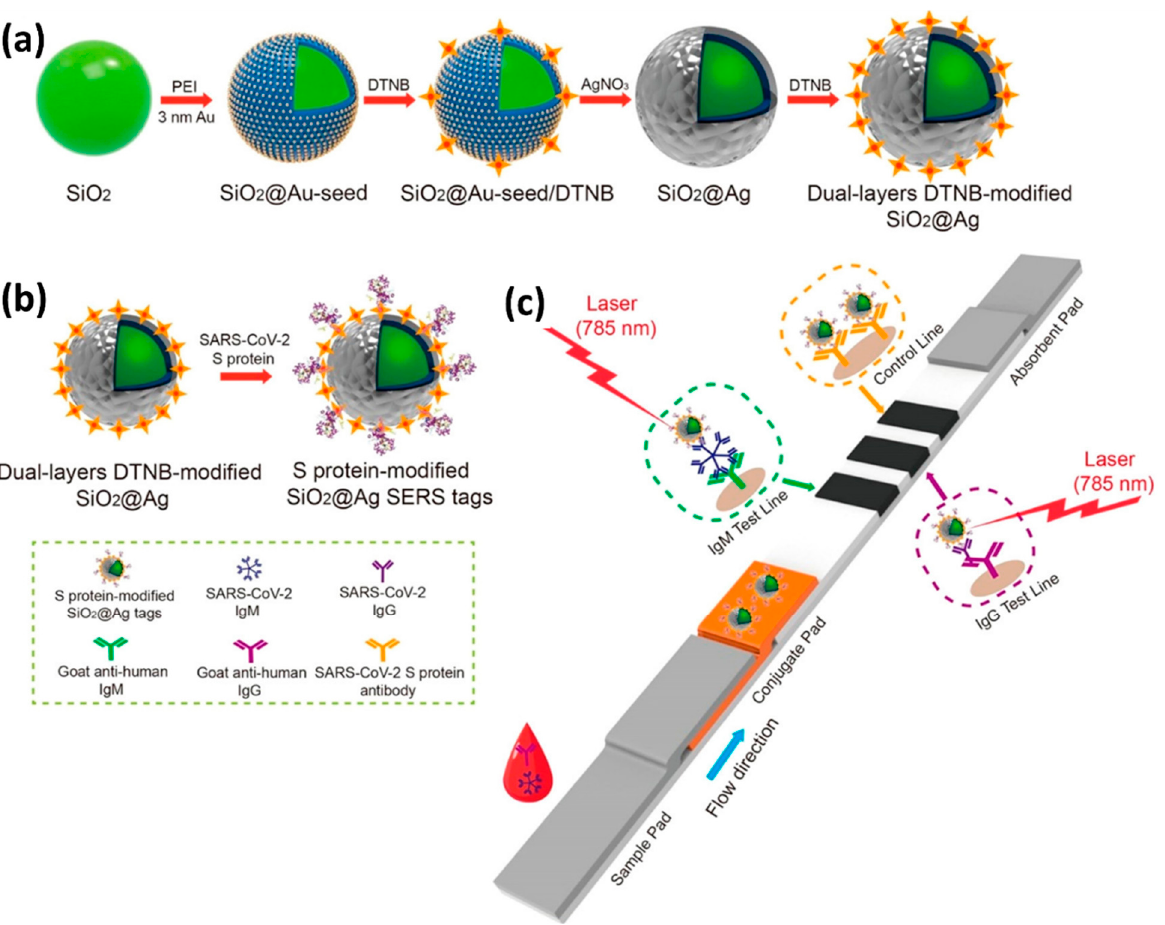
Figure 9. ( a ) Schematic of the dual-layer Raman reporter molecule 5,5 ′ -dithiobis(2-nitrobenzoic acid (DTNB) modified SiO 2 -Ag Nanoparticles via LFIA. ( b ) SARS-CoV-2 S-protein-modified SiO 2 -Ag SERS probes preparation. ( c ) The SERS-LFIA strip’s operating concept for simultaneous high-sensitivity anti-SARS-CoV-2 IgM/IgG identification. Reproduced with permission from ref. [130]. Copyright 2021 Elsevier.